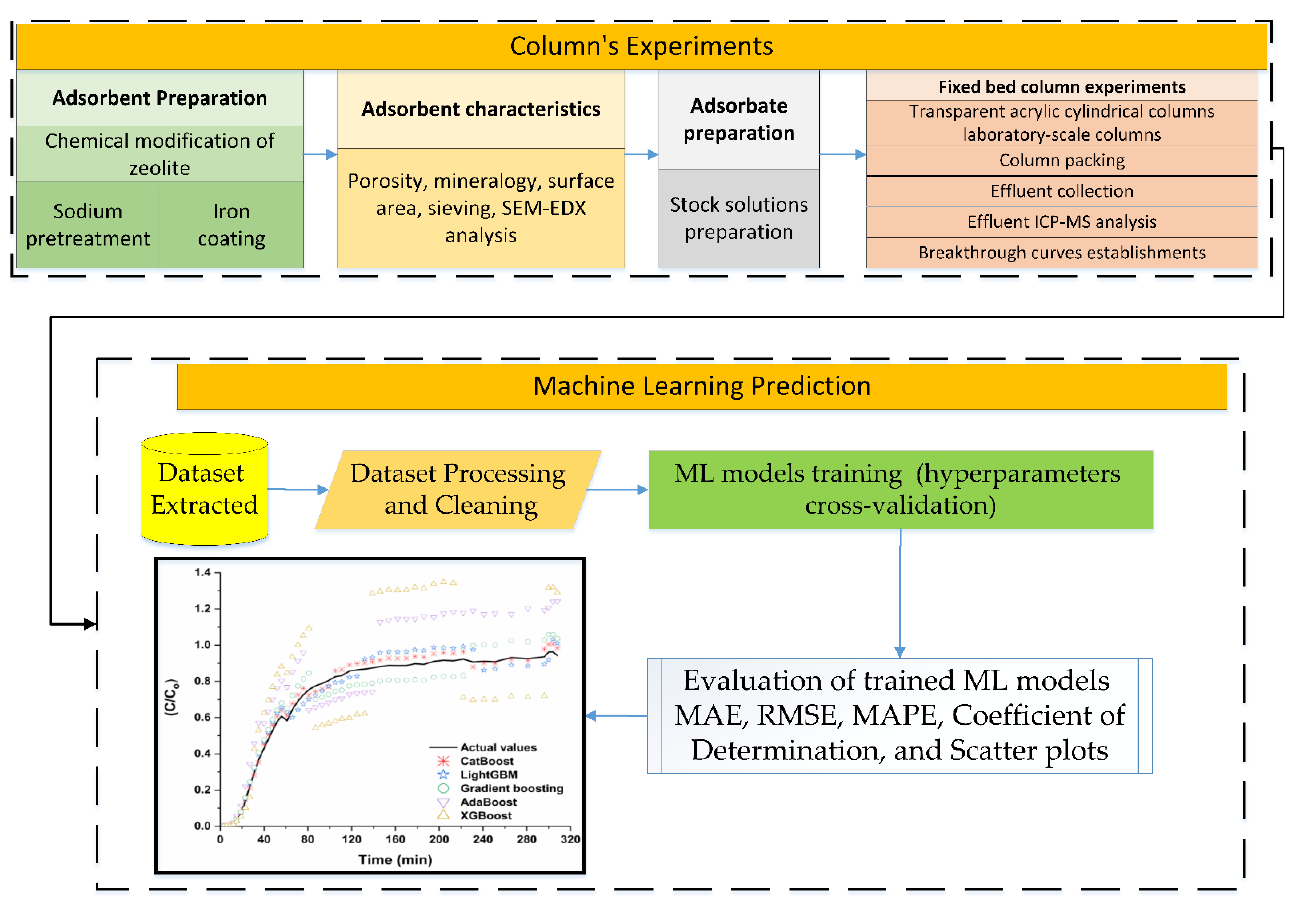
Figure 1. Methodology flowchart.